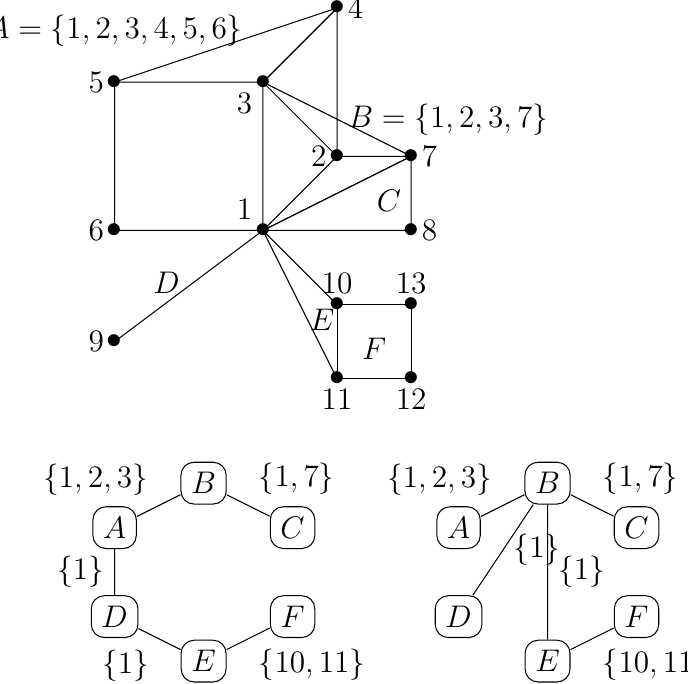
Figure 1. A graph G and two atom trees of G Figure 1: A graph G and two atom trees of G .